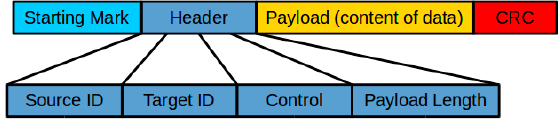
Figure 10. Format of frame.